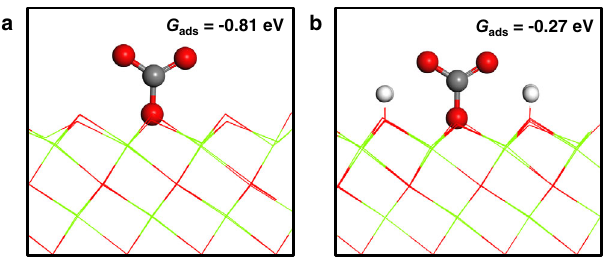
Fig. 4 Calculated structures of CO 2 adsorption on MgO. CO 2 unidentate adsorption on pristine MgO(111) ( a ) and MgO(111)-4H ( b ). Hydrogen, oxygen, carbon, and magnesium atoms are in white, red, gray, and green, respectively. Oxygen and magnesium atoms uncoordinated to CO 2 are displayed with